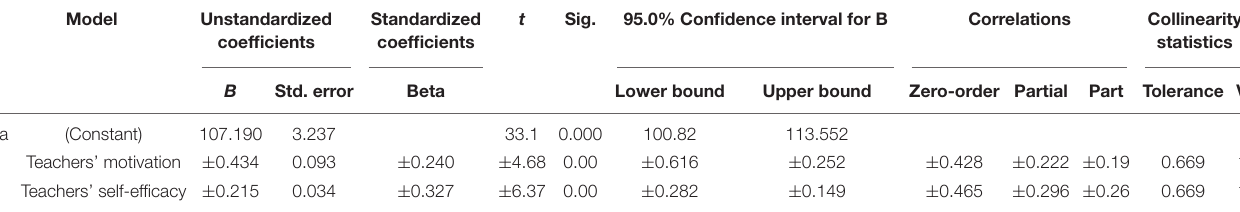
TABLE 2 | Coefficients for teachers’ self-efficacy and motivation as predictors of burnout.